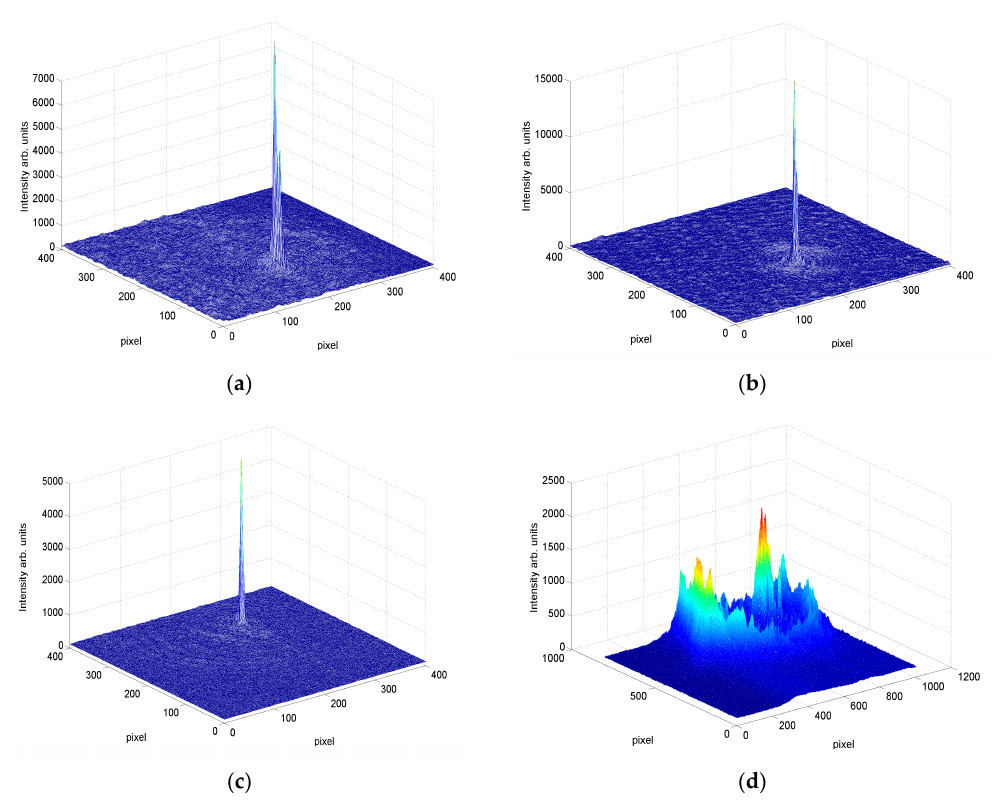
Figure 7. Point spread function ( a ) Just after recording for coverplated samples; ( b ) Just after recording for uncovered samples; ( c ) After 8 weeks for coverplated samples; ( d ) After 4 weeks for uncovered samples.